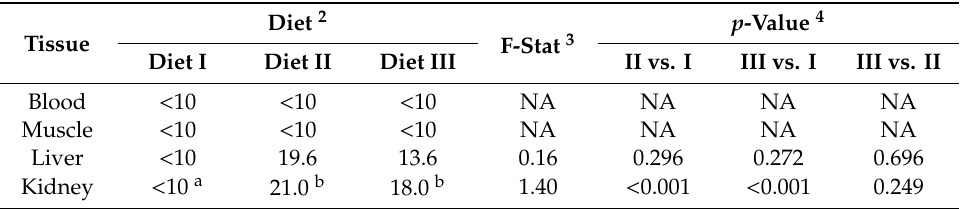
Table 4. The arsenic (As) concentrations (ppb, as is) in di ff erent tissues of the pigs fed with three experimental diets 1